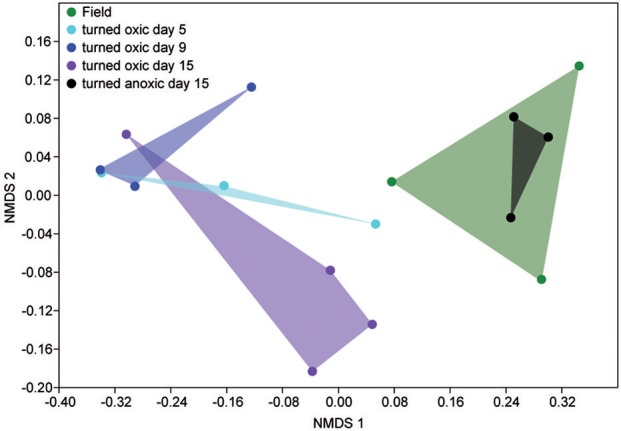
NMDS plot based on the relative abundance of sediment 16S rRNA gene OTUs. Shaded areas denote: field samples, green; “turned oxic” day 5, turquoise; “turned oxic” day 9, blue; “turned oxic” day 15, purple; “turned anoxic” day 15, black.